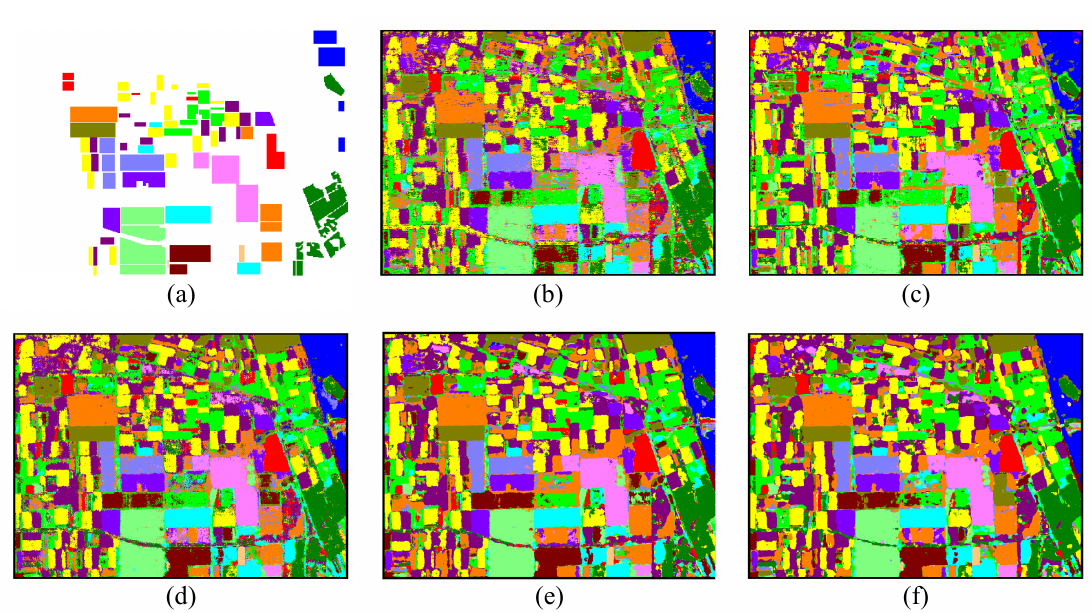
Figure 12. Classification results of the whole map on the AIRSAR Flevoland data with different methods. ( a ) Ground truth. ( b ) Result of CNN. ( c ) Result of depthwise separable (DW)-CNN. ( d ) Result of 3D-CNN. ( e ) Result of P3D-CNN. ( f ) Result of 3D-depthwise separable convolution-based CNN